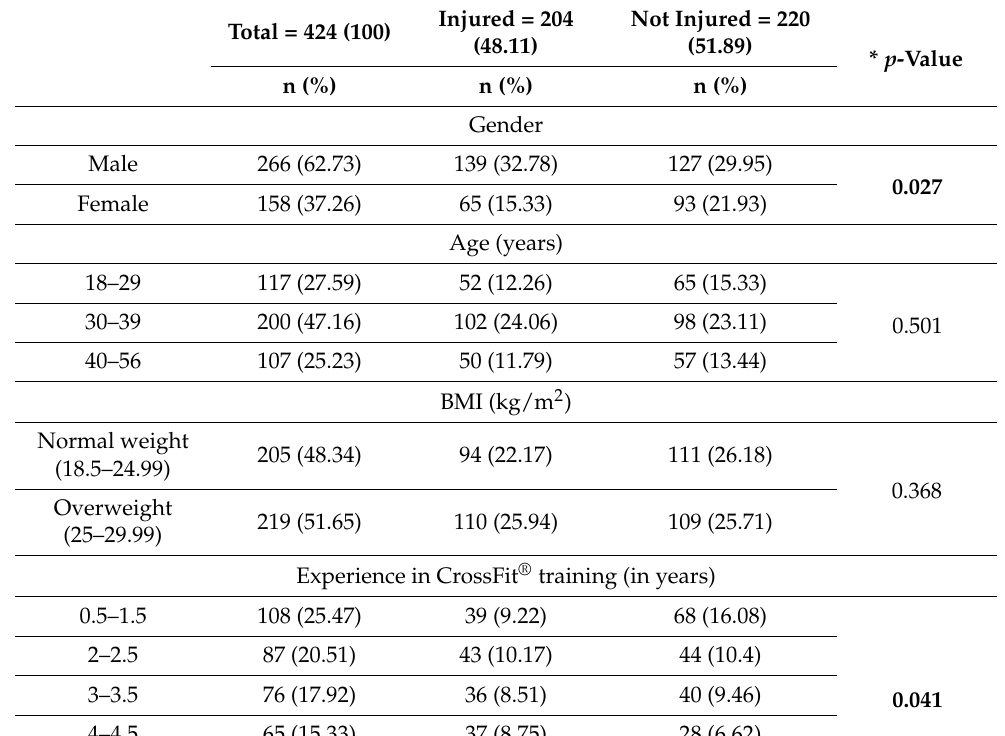
Table 2. Relationship between injuries incidence and respondents’